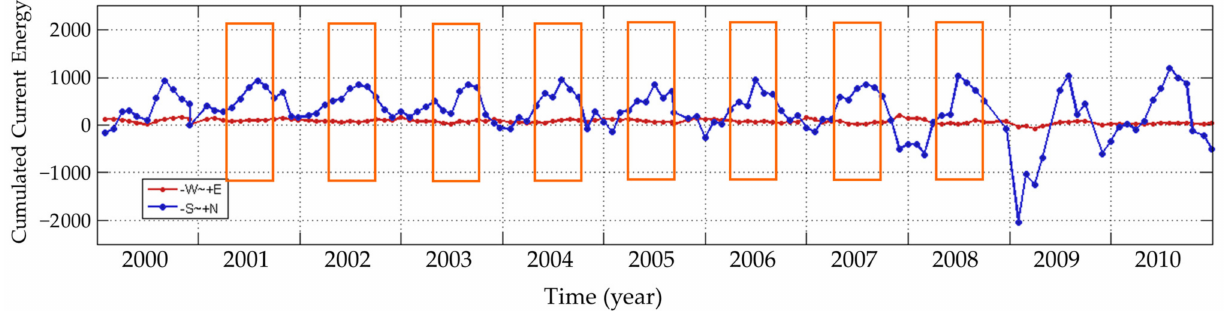
Figure 16. Cumulated current energy in 11 consecutive years.